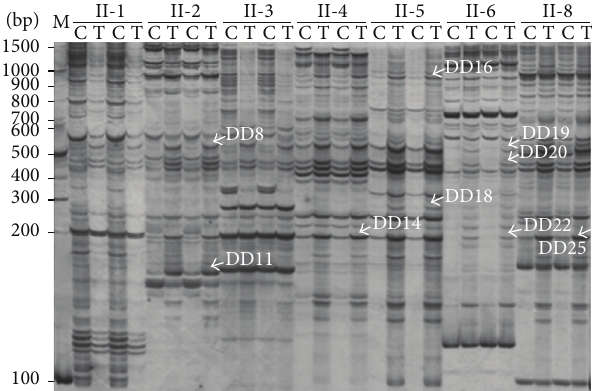
Figure 1: Representative 6% denaturing polyacrylamide gel from a differential-display experiment. Differences between control and NaCl-treated tissues detected by DDRT-PCR with arbitrary primers (1, 2, 3, 4, 5, 6, and 8 in Table 1) in combination with the anchor primer II (Table 1) are shown. II-1, II-2, II-3, II-4, II-5, II-6, and II-8 represent the primer combinations. Lanes C and T contain the PCR products from the control and treated samples, respectively. Lane M contains a 100-bp DNA ladder marker. Arrows indicate the recov- ered differentially expressed cDNA fragments. Arbitrary primer 7 (Table 1) failed to generate any fragment length